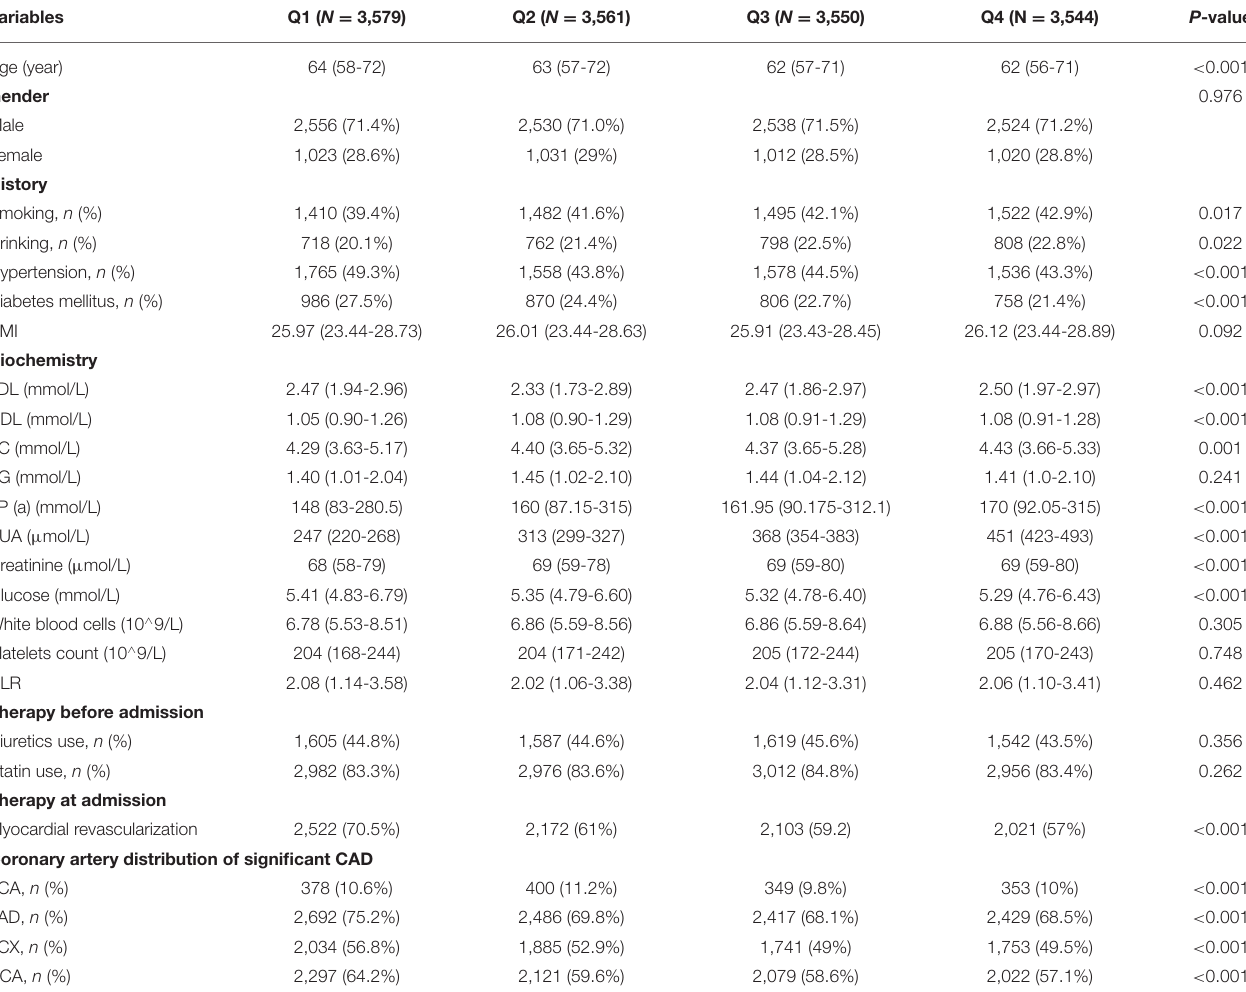
TABLE 1 | Baseline characteristics of the